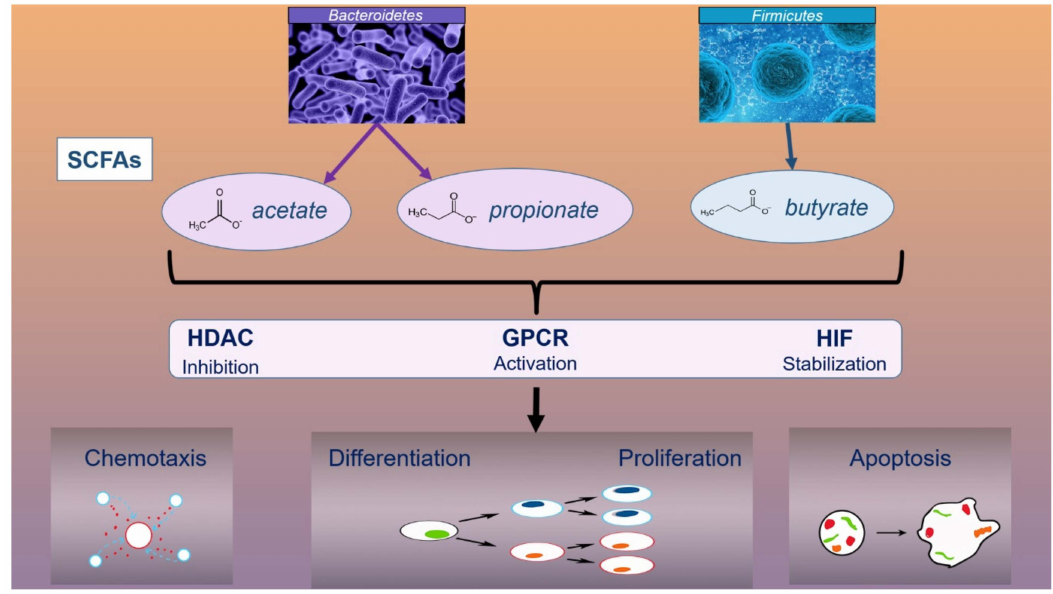
Figure 2. The role of SCFAs in immunomodulation Abbreviations: SCFAs, short chain fatty acids; HDAC, histone deacetylases; GPCR, G protein coupled receptors; HIF, hypoxia-inducible